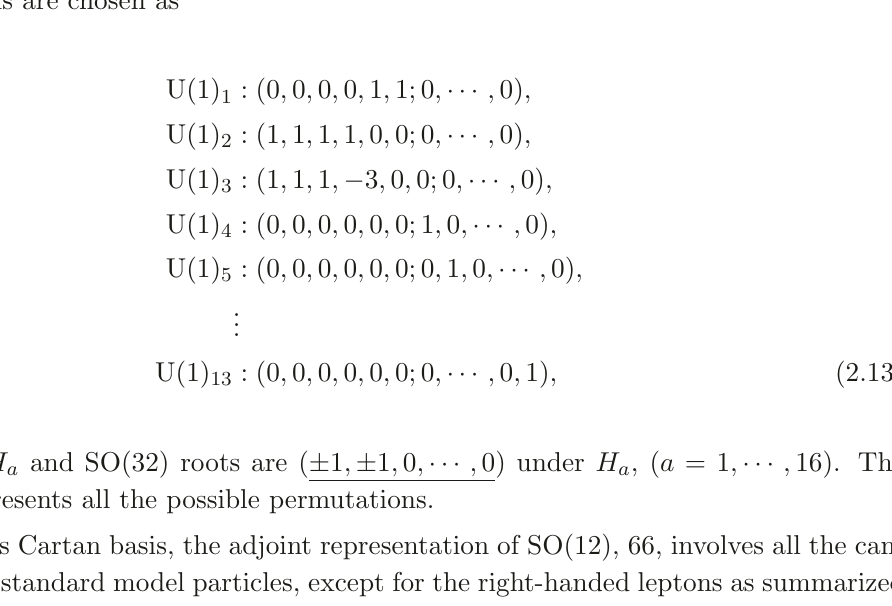
Under the above decomposition, we take the Cartan directions of SO(32), H a ( a = 1 , 2 , , 16), as H 1 H 2 and H 1 + H 2 2 H 3 for SU(3) C and H 5 · · · − −